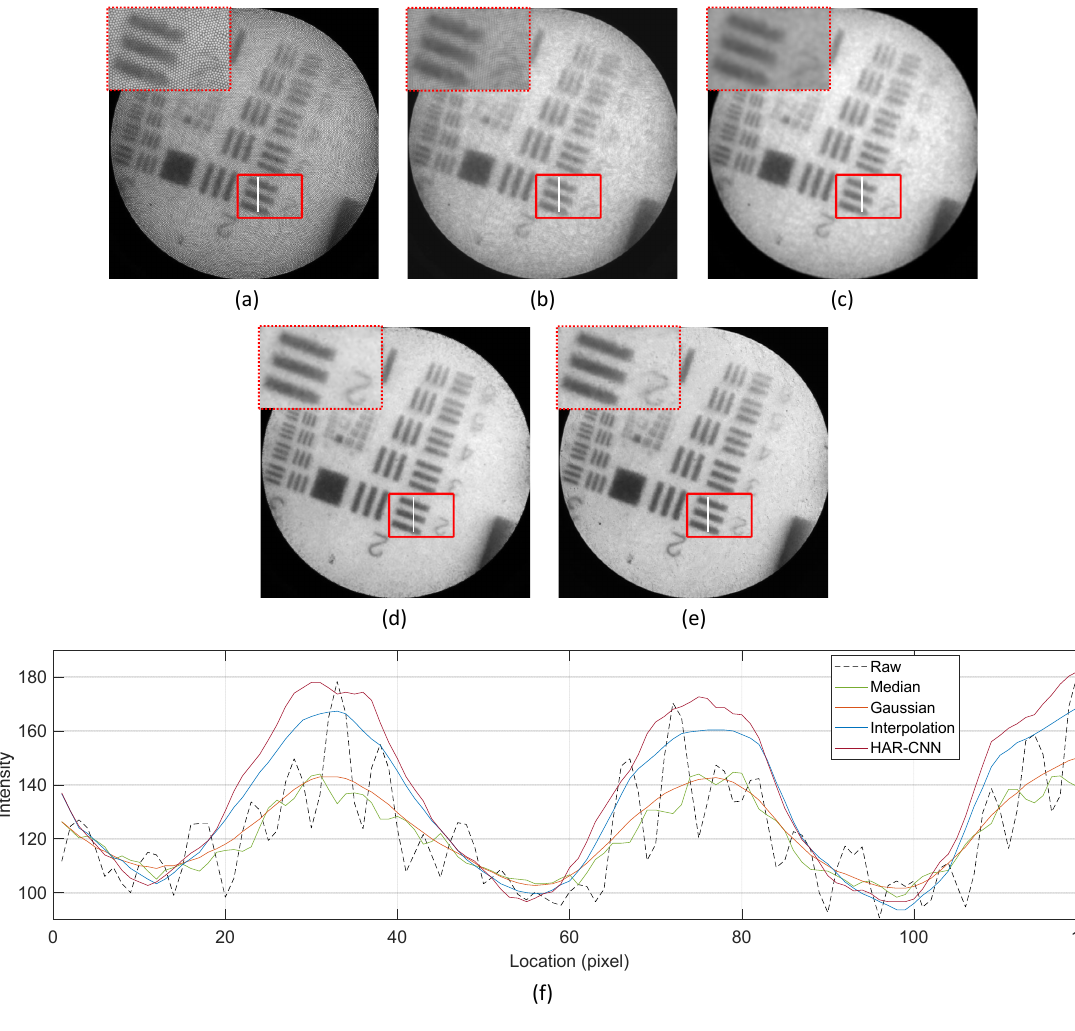
Figure 6. Resulting images for various honeycomb removal methods on the USAF target sample: ( a ) raw fiber bundle image, ( b ) median filter, ( c ) Gaussian filter, ( d ) interpolation, ( e ) HAR-CNN. ( f ) Pixel intensities along a line of interest shown as a white line within the line-patterned region, where the values are averaged across a column width of